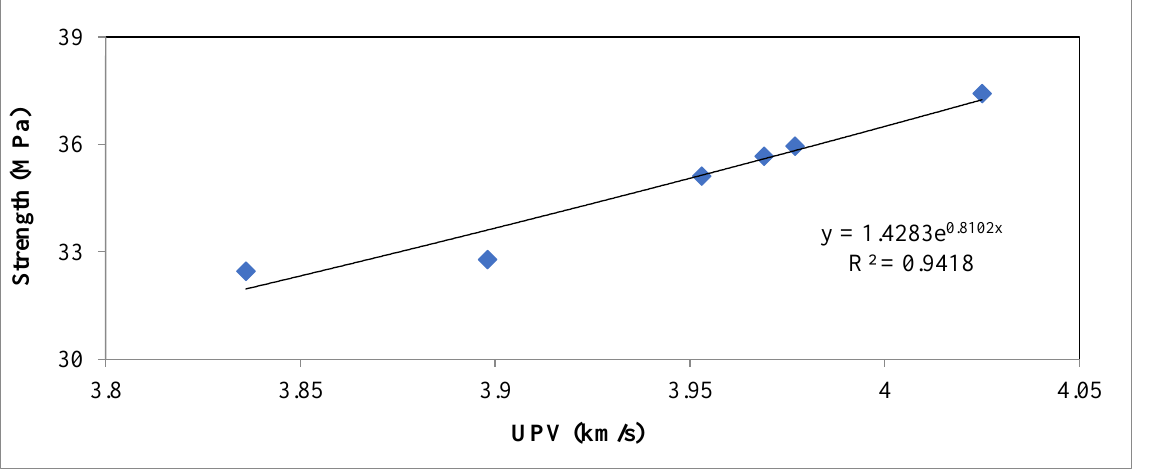
Figure 10. Correlation between compressive strength and UPV.